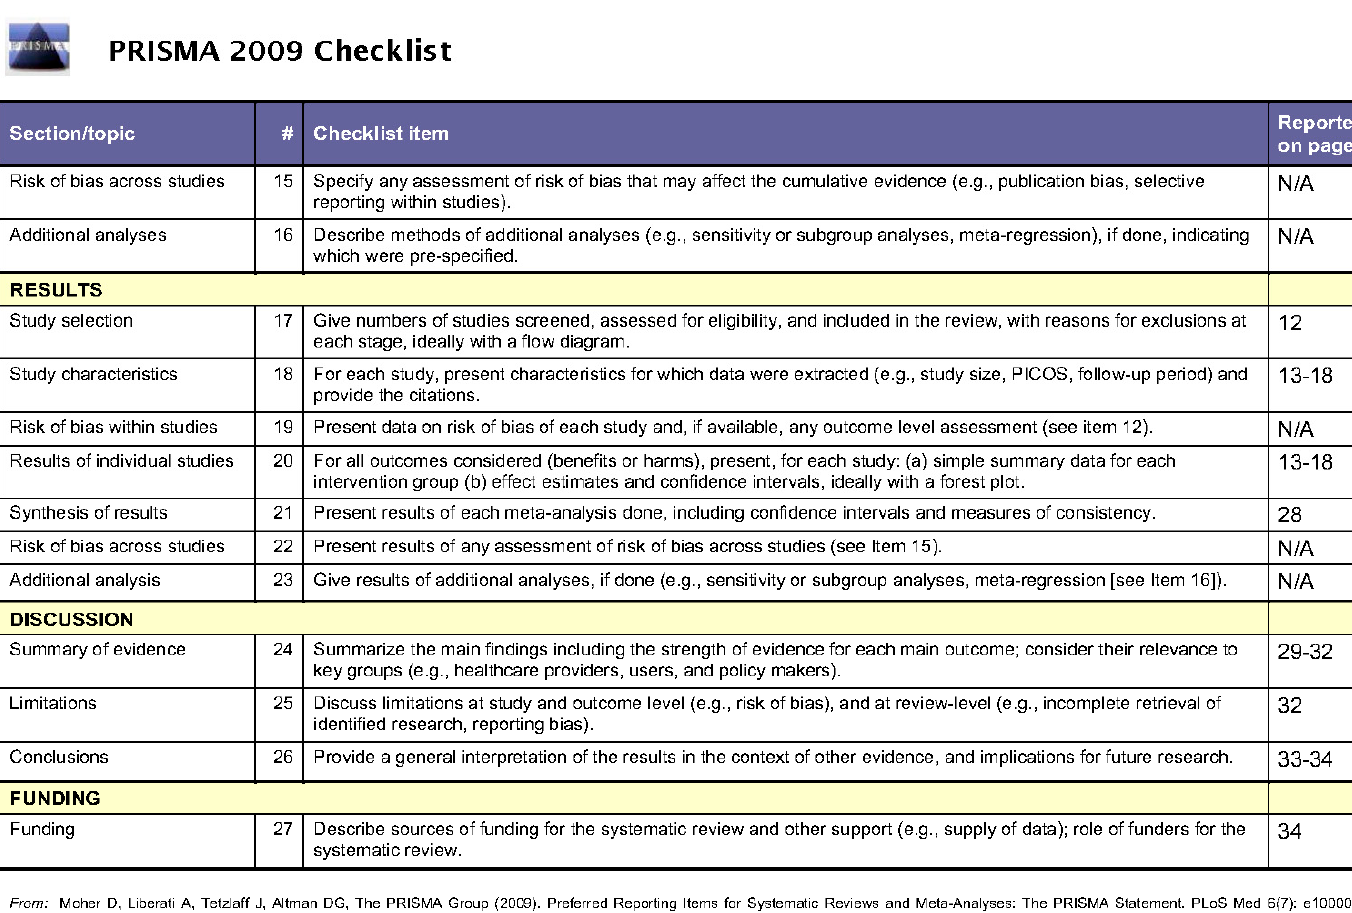
Figure A2. PRISMA Figure A2. P RISMA Checklist.